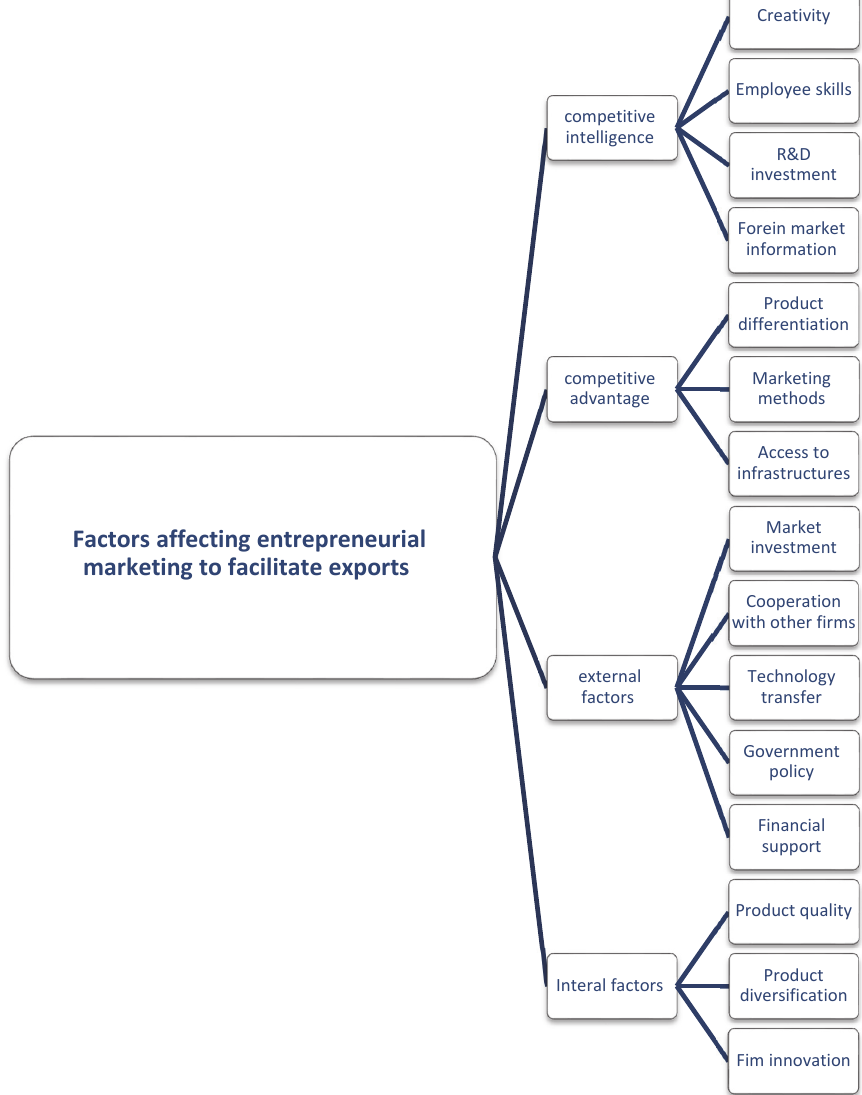
Fig. 2. The results of principle component